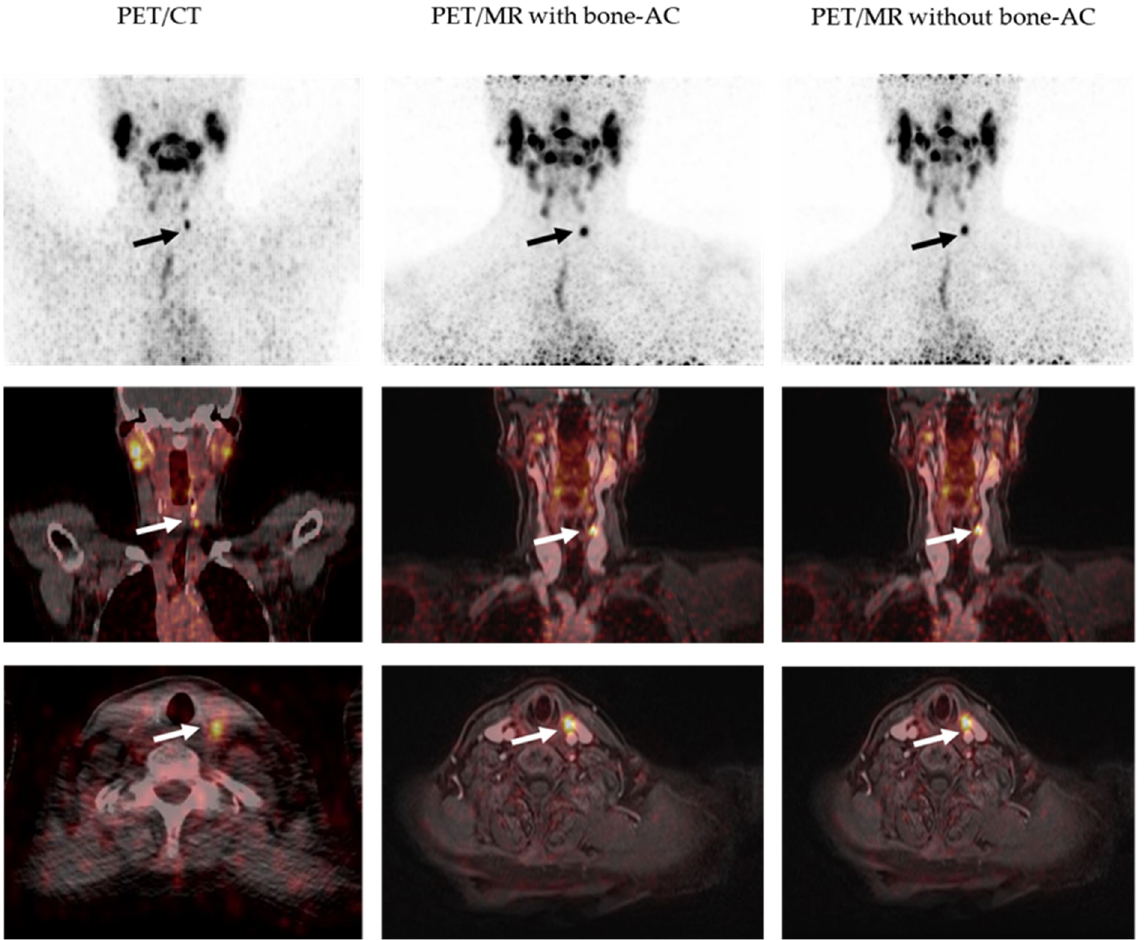
Figure 2. Intra ‐ individual comparison of 124 I ‐ PET/CT and PET/MR examinations acquired Figure 2. Intra-individual comparison of 124 I-PET/CT and PET/MR examinations acquired approxi- approximately 24 h post ‐ 124 I administration. From left to right column: PET/CT, PET/MR mately 24 h post- 124 I administration. From left to right column: PET/CT, PET/MR reconstructed reconstructed with bone AC, and PET/MR reconstructed without bone AC. All hybrid data sets with bone AC, and PET/MR reconstructed without bone AC. All hybrid data sets exemplarily show exemplarily show the uptake of a 124 I ‐ avid left cervical lesion (arrows). The lesion is well visible on the uptake of a 124 I-avid left cervical lesion (arrows). The lesion is well visible on all PET reconstruc- all PET reconstructions (arrows) and presents with slightly improved visibility on the PET/MR ‐ based reconstructions (middle and right column). tions (arrows) and presents with slightly improved visibility on the PET/MR-based reconstructions (middle and right